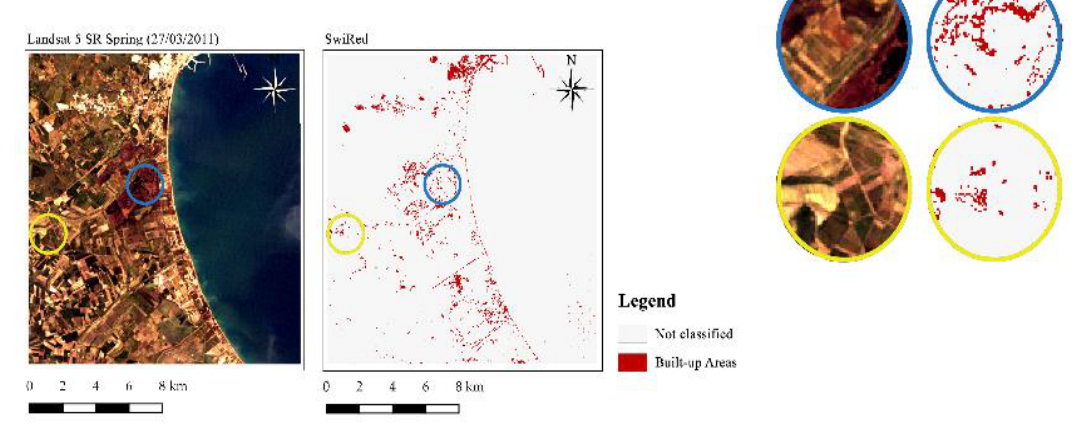
Figure 11. SwiRed index (SwiRed) classification outcome for Landsat 5 (image acquired on 5 October 2011). On the right, zoomed images with some misclassifications.